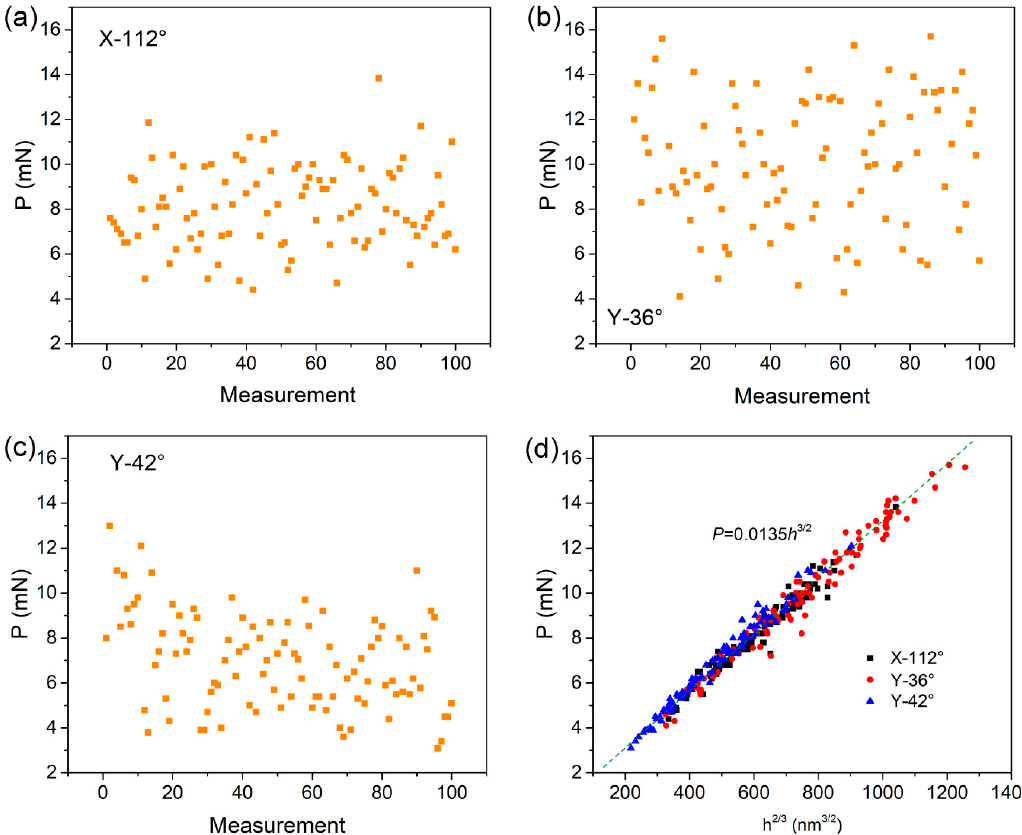
Figure 2. The distribution of critical load at the first pop-in event as a function of measurements for ( a ) X-112° plane, ( b ) Y-36° plane, and ( c ) Y-42° plane; ( d ) Statistics of 100 P–h 1.5 pairs on the first pop-